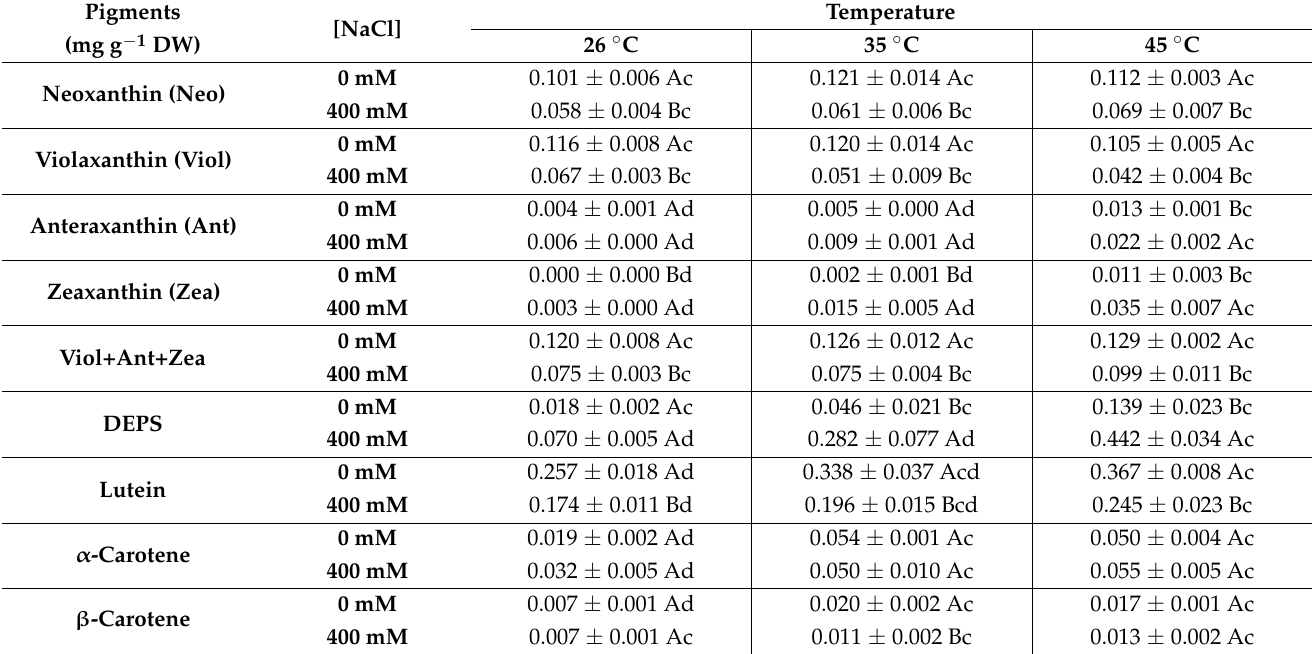
Table 2. Photosynthetic pigments in C. glauca branchlets under the single and combined exposure to salt (0 and 400 mM NaCl) and temperature (26, 35 and 45 ◦ C) conditions. The de-epoxidation state (DEPS) was determined as DEPS = [(Zeaxanthin (Zea) + 0.5 × Antheraxanthin (Ant))/(Violaxanthin (Viol) + Ant + Zea)]. Each value represents the mean ± SE of three to five independent measurements. Two-way ANOVA ( p < 0.05) followed by Tukey’s HSD test was for performed for means comparison and different letters express significant differences between [NaCl] for the same temperature (A, B) or between temperature for the same [NaCl] (c, d) with A and c representing the highest